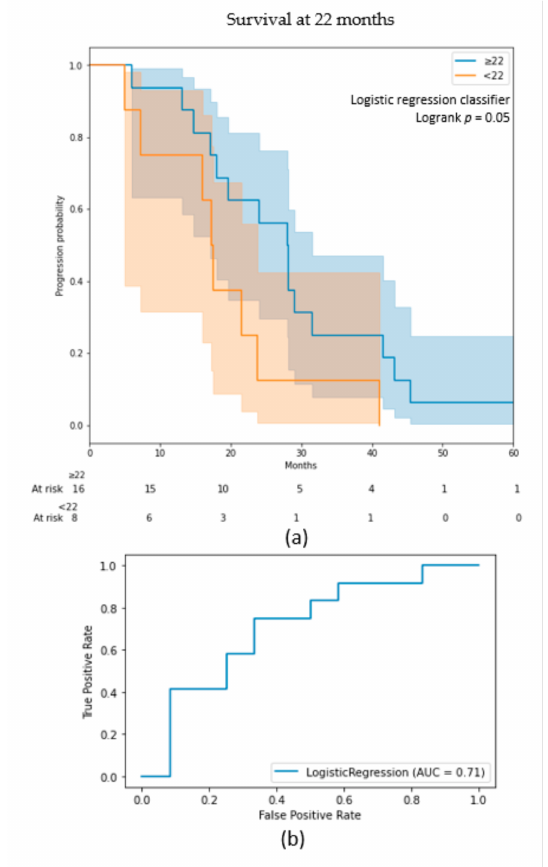
Figure 3. ( a ) Kaplan–Meier curve of the results on the test-set for the 22-months model; ( b ) receiver operating characteristic (ROC) curve of the results on the test-set for 22-months model. Table 5. Essential features found in the feature selection based on their C-index with the OS on the train sets.